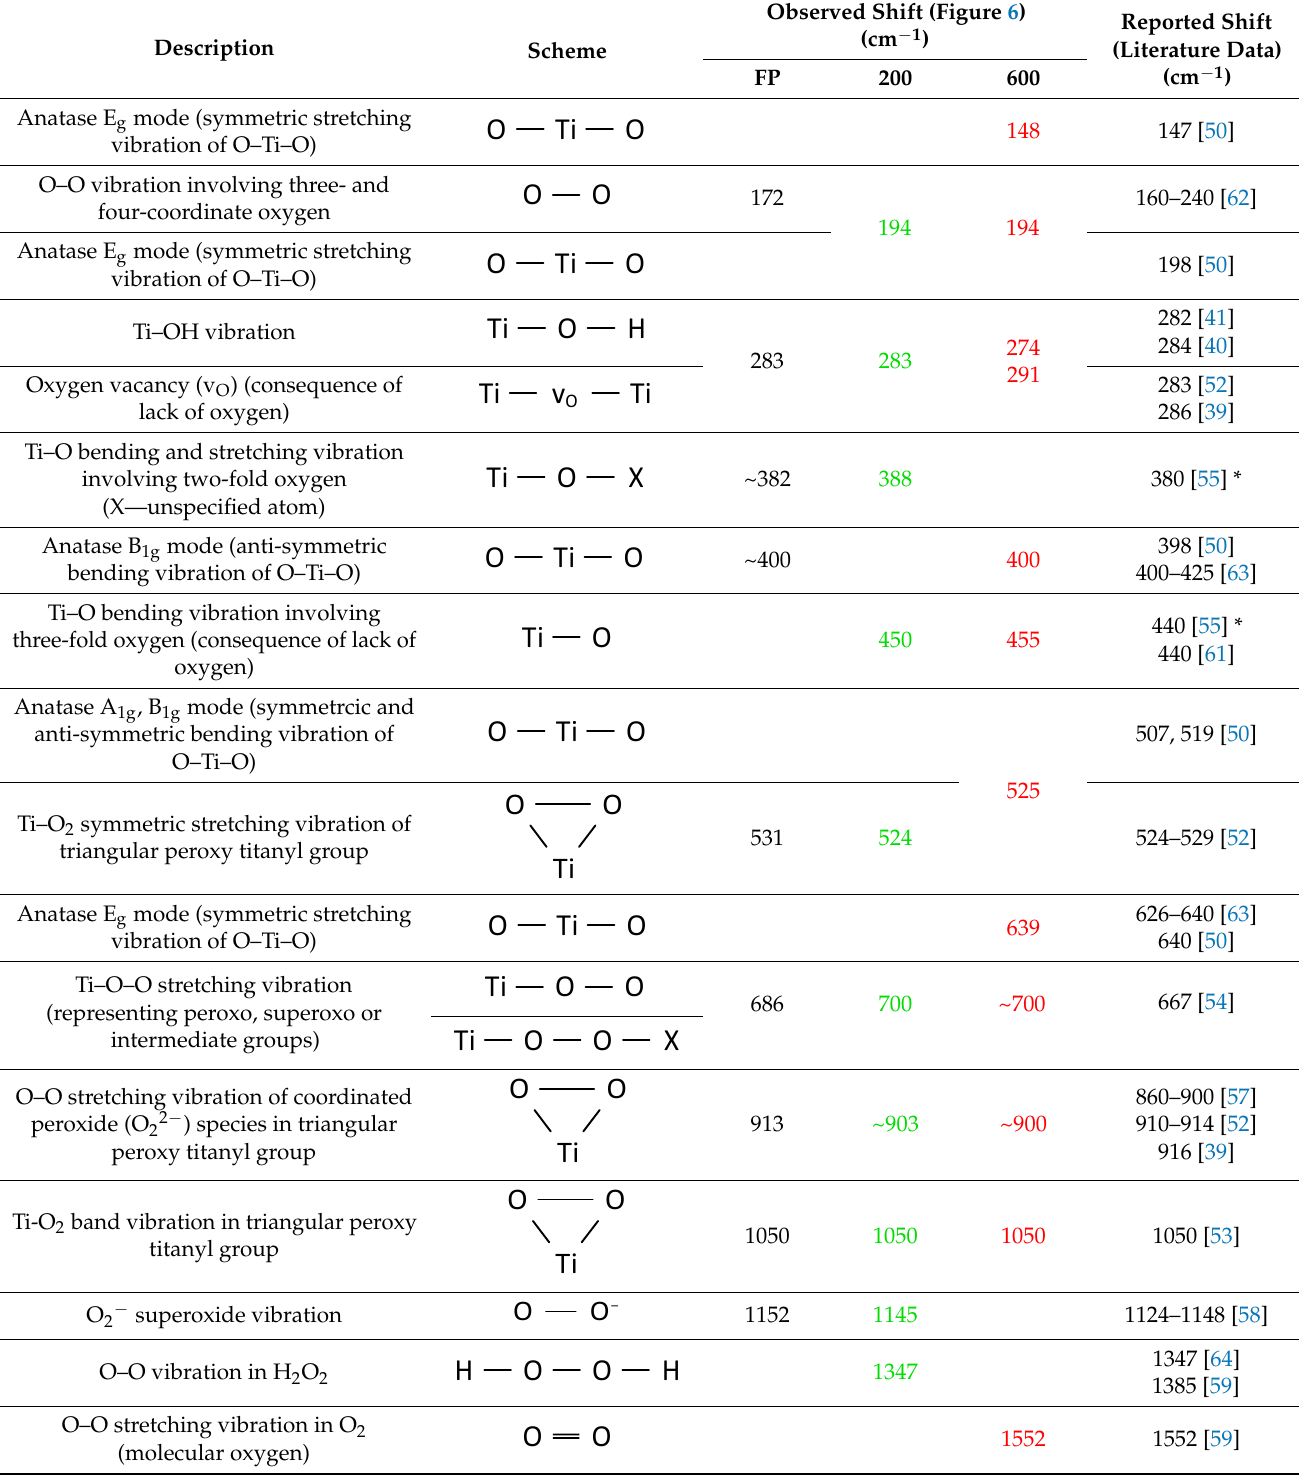
Table 1. Assignments of the Raman bands in feedstock powder (black), sample 200 (green), and 600 (red).